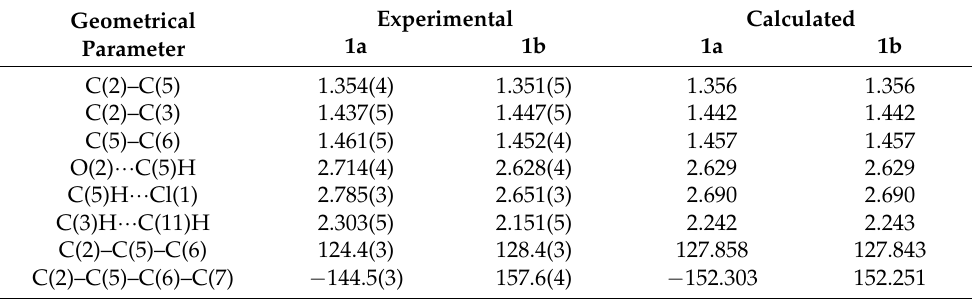
Table 3. Comparison of some important geometrical parameters (bonds and interatomic distances (Å), and angles and torsions ( ◦ )) of the rotamers from the X-ray study and calculations of each rotamer